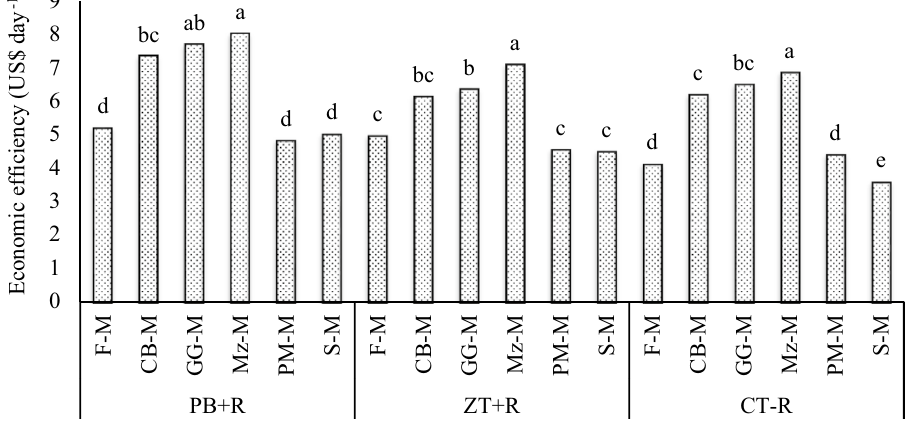
Figure 5. Economic efficiency of CA-based Indian mustard systems (3-year mean).